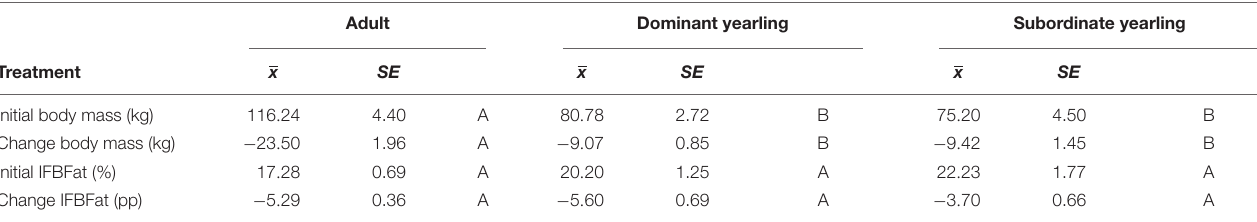
Different letters correspond to statistically significant differences between